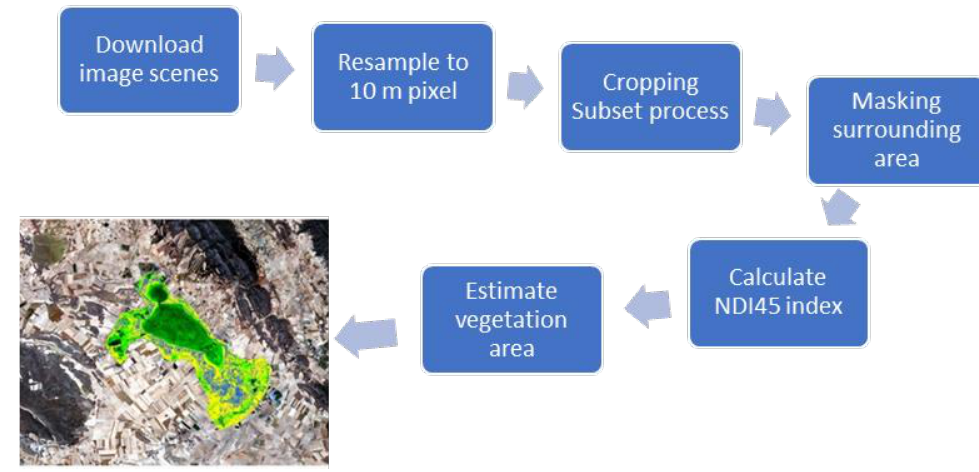
Figure 2. Process flux diagram of Sentinel-2 satellite imagery to obtain a thematic map.